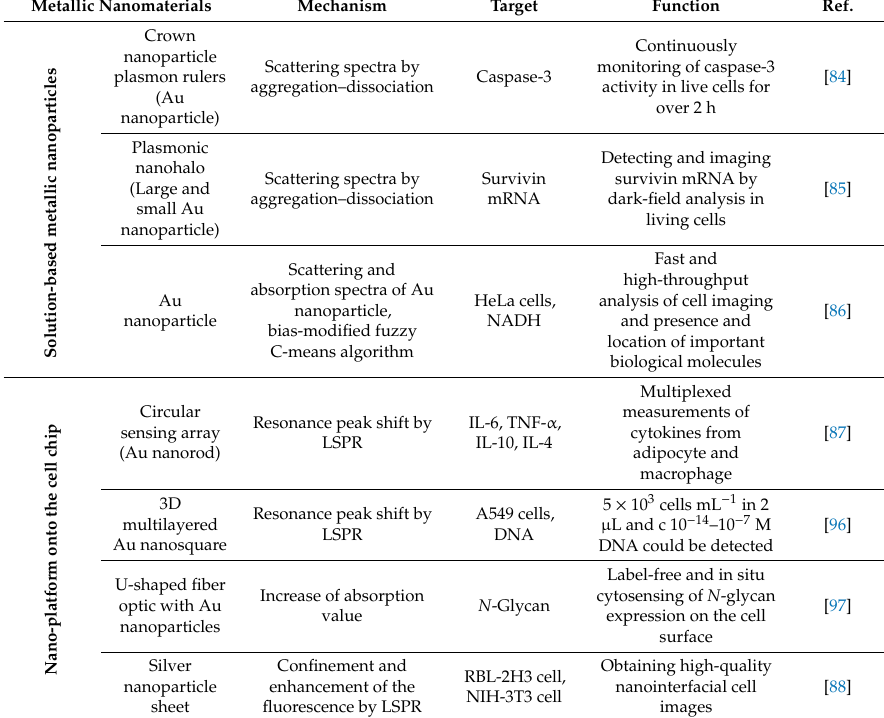
Table 2. LSPR-based analytical platforms for the cell analysis with the metallic nanomaterials. Metallic